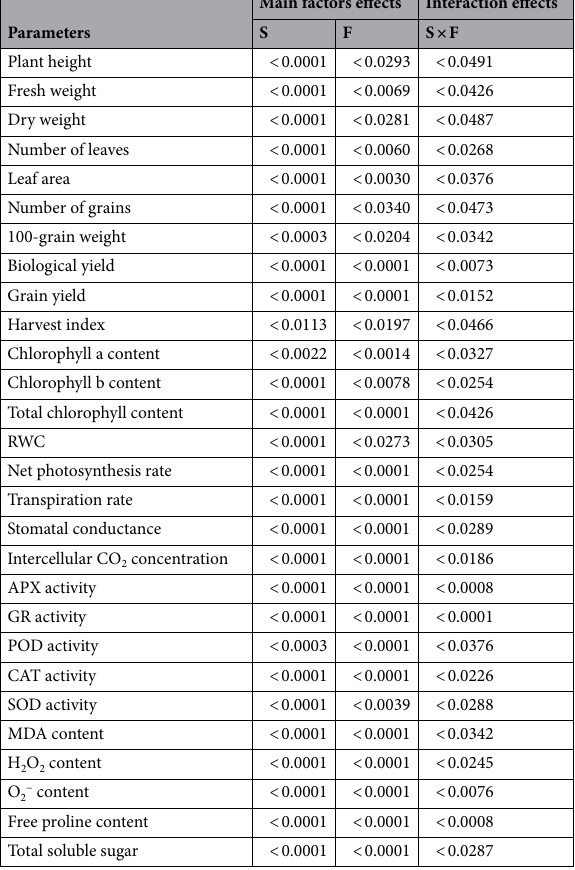
Table 3. p-values of the two-way factorial analysis of growth, yield, and physiological and biochemical parameters of maize as influenced by various foliar treatments under both soil water conditions. ‘S’: effect of soil water conditions; ‘F’: effect of foliar treatments; S × F, effect of the interaction between two variables. p-values are regarded as significant (p < 0.05, n = 3) and highly significant (p < 0.01, n = 3).